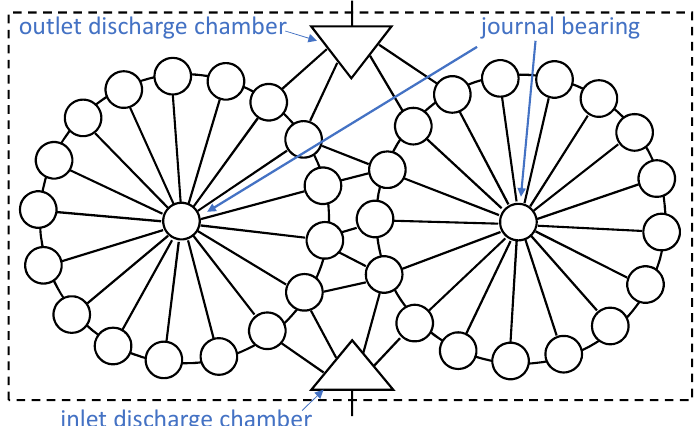
Figure 7. The hydraulic circuit used in the HYGESim simulation tool for modeling the displacing action of and EGP. The representation for the hydraulic circuit of an EGP is similar to